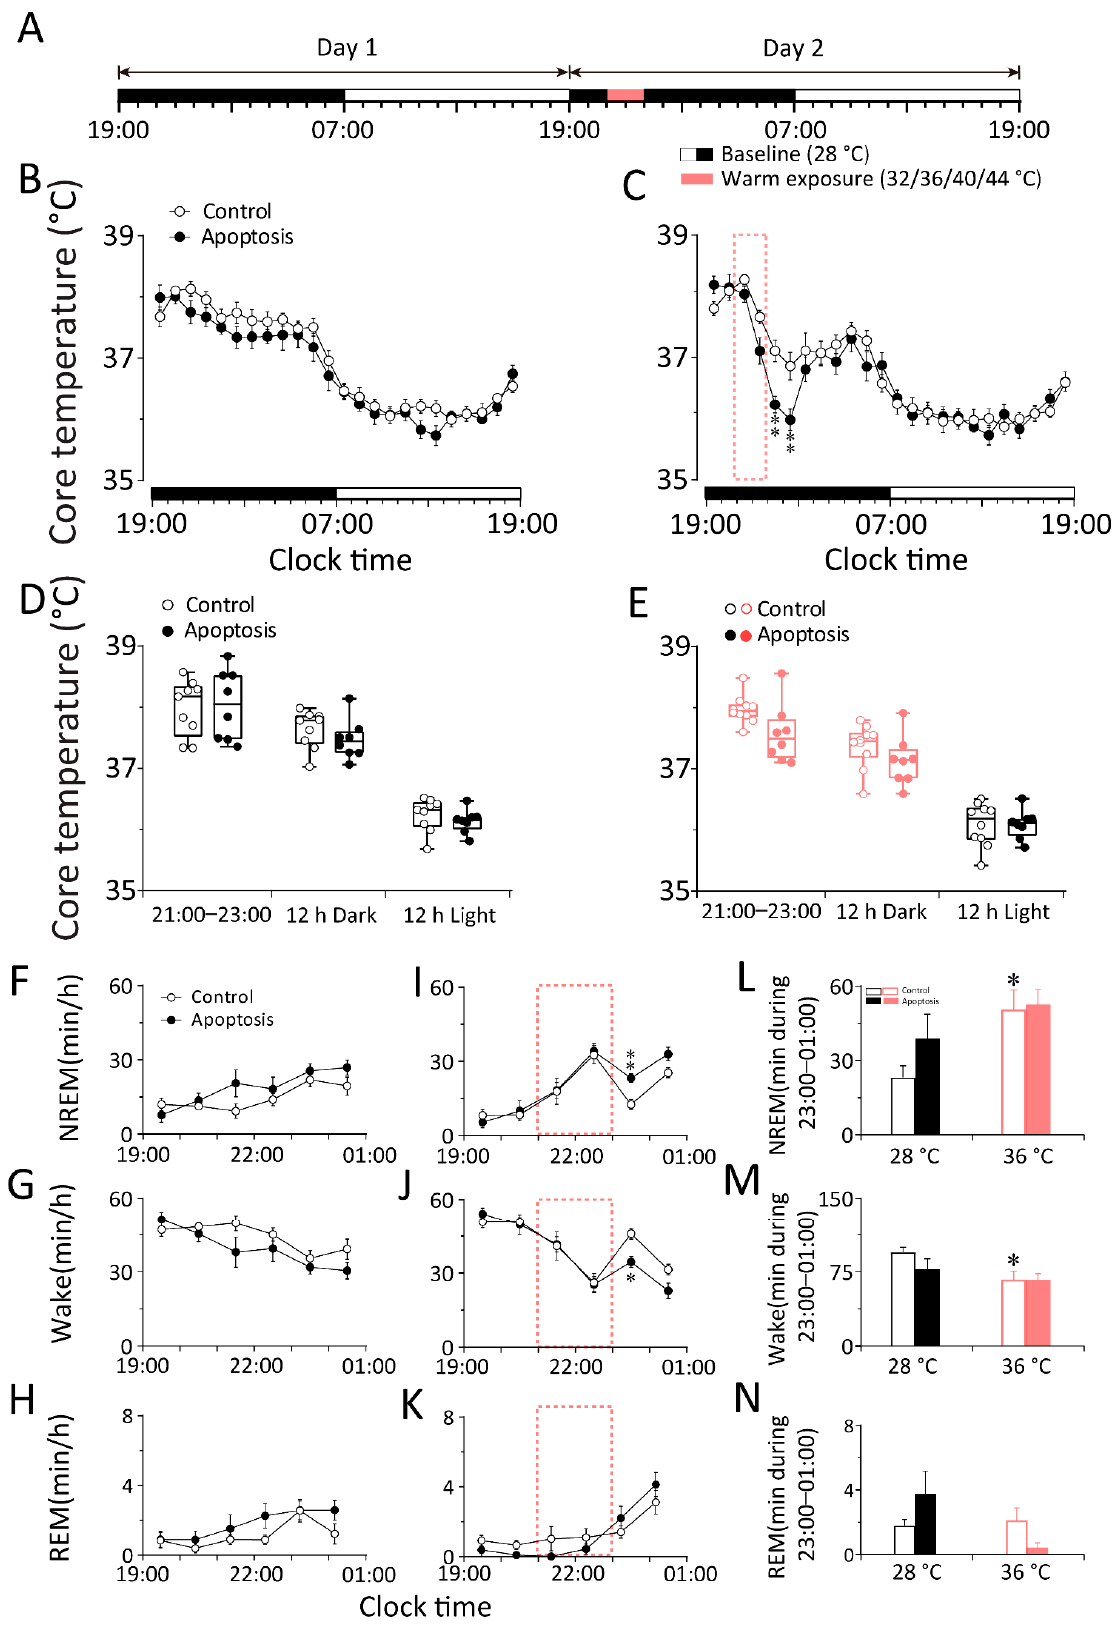
Figure 4. The apoptosis of DMH neurons increased the core temperature fluctuation elicited by warm exposure and alleviated the NREM sleep elicited by warm exposure in WT mice. ( A ) The